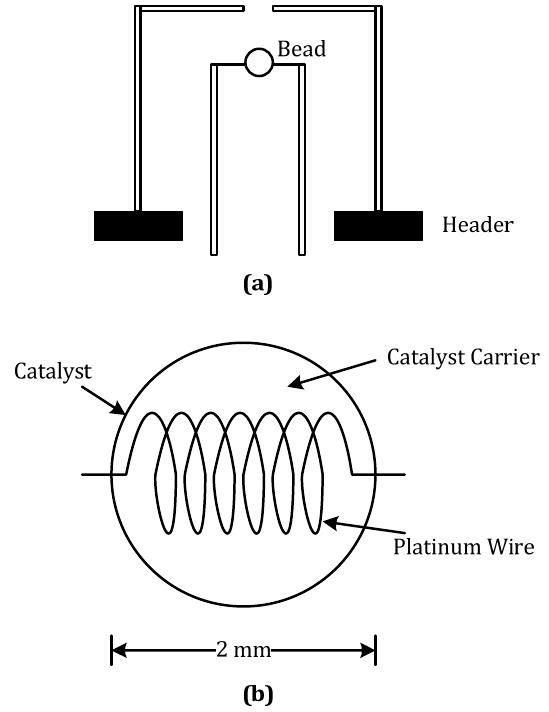
Figure 5. Catalytic sensor ( a ) schematic diagram and ( b ) configuration of ceramic